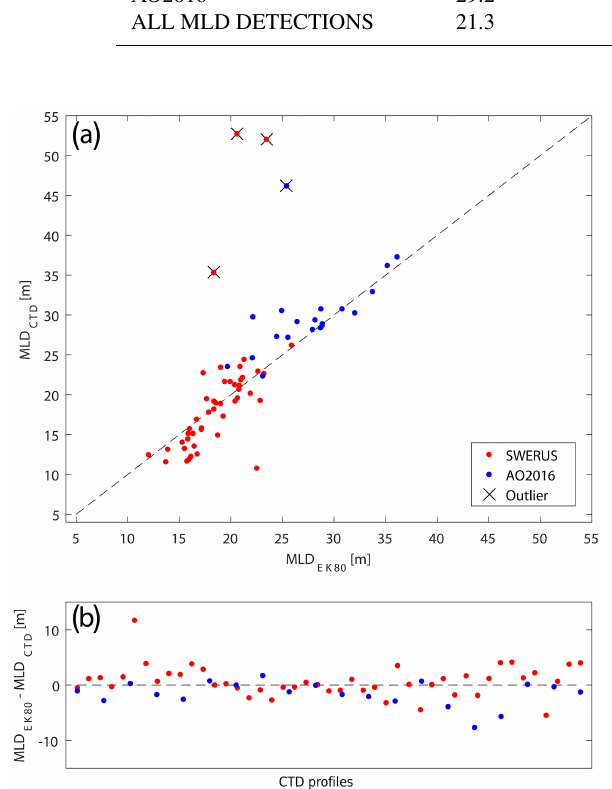
Figure 3. (a) MLD for the individual stations derived from CTD (MLD CTD ) vs. MLD derived from EK80 data (MLD EK80 ) . (b) Dif- ference between MLD EK80 and MLD CTD . In total, four outliers (black crosses in a ) for which the (cid:49)T threshold method fails (as ex- emplified in Fig. S2) are excluded from the statistics. Note that the original (cid:49)T threshold (0.2 ◦ C) as presented in de Boyer Montégut et al. (2004) generally failed in the central Arctic Ocean (Fig. S3) and that we instead used a modified (cid:49)T threshold of 0.05 ◦ C on CTD data from